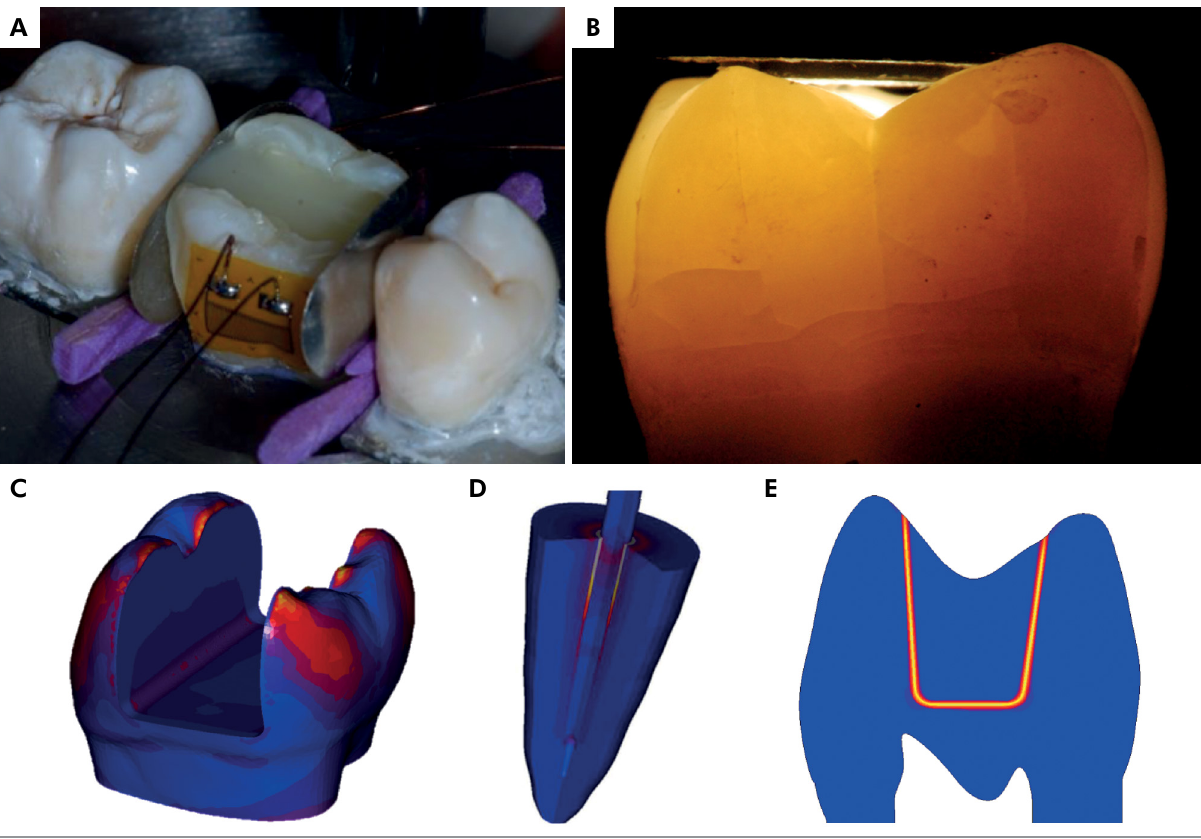
Figure 4. Experimental methods used for measuring polymerization shrinkage stress effect – A. strain-gauge used for measuring cusp deformation; B. transillumination of MOD cavity after incremental filling technique showing enamel crack; C. 3D finite element model of bulk fill restoration; D. Axisymmetric model of resin cementation of fiber post; E. 2D model of ceramic inlay